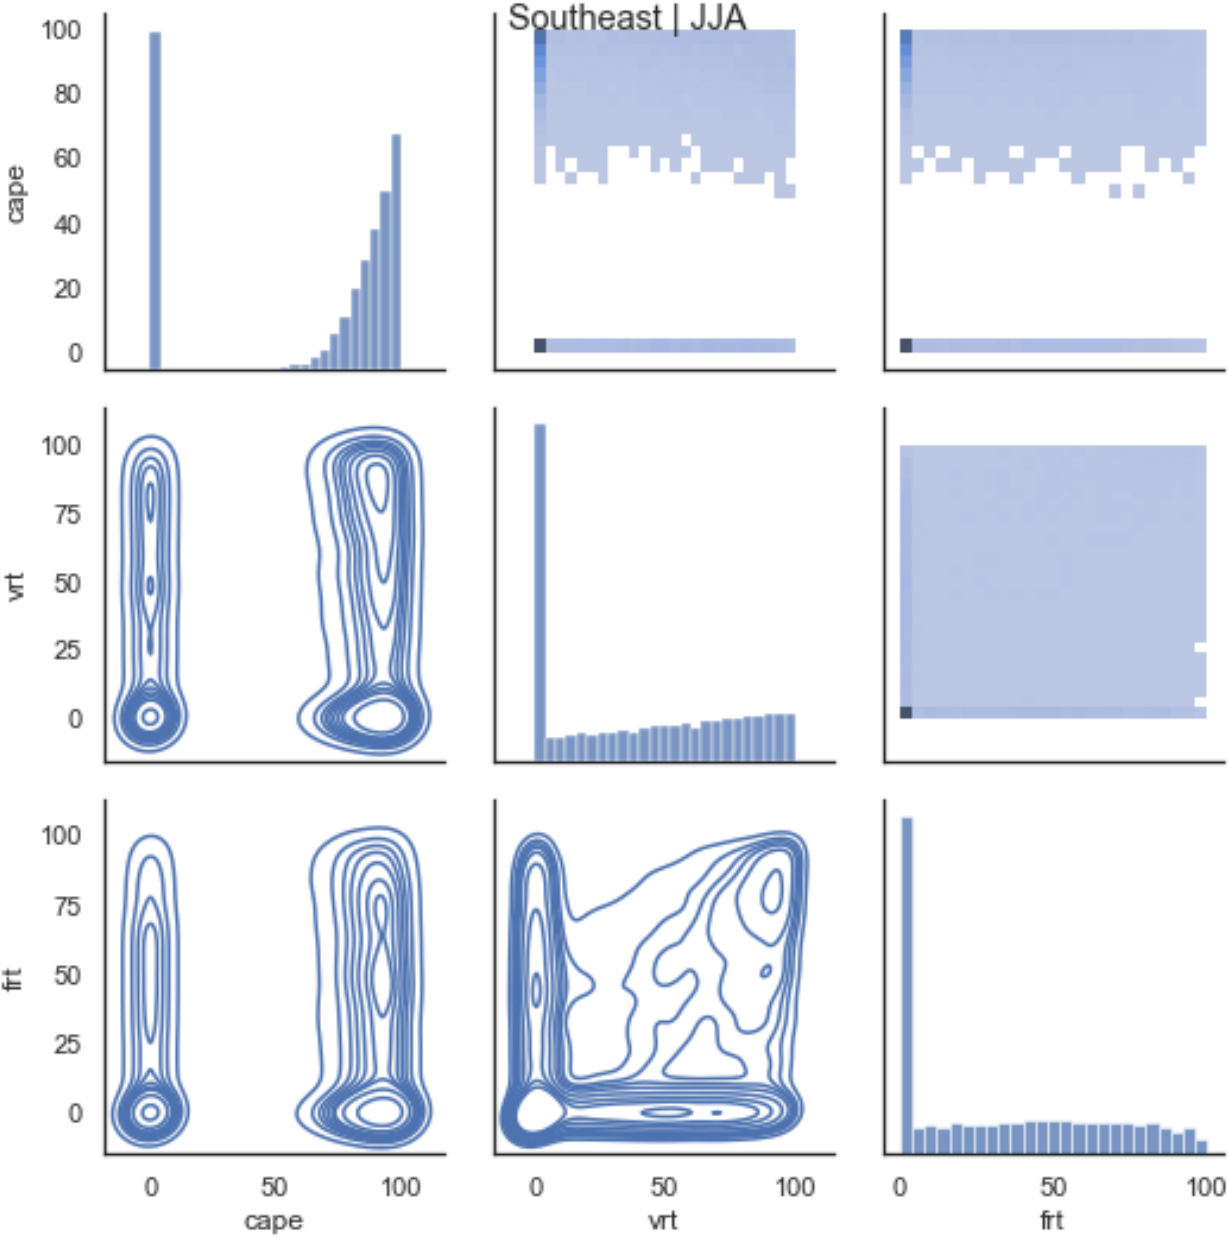
Figure 3. The plots along the diagonal are the univariate distribution of each of the three processes (Convection, Vorticity, and Frontal). The x -axis is the rank of the process (broken into 25 bins) and the y -axis is the number of events in that bin (the y -axis labels do not apply to the panels on the diagonal). The lower triangular panels show a kernel density plot of the two processes indicated on the corresponding x and y axis labels. The upper triangular panels show the same data as a bivariate